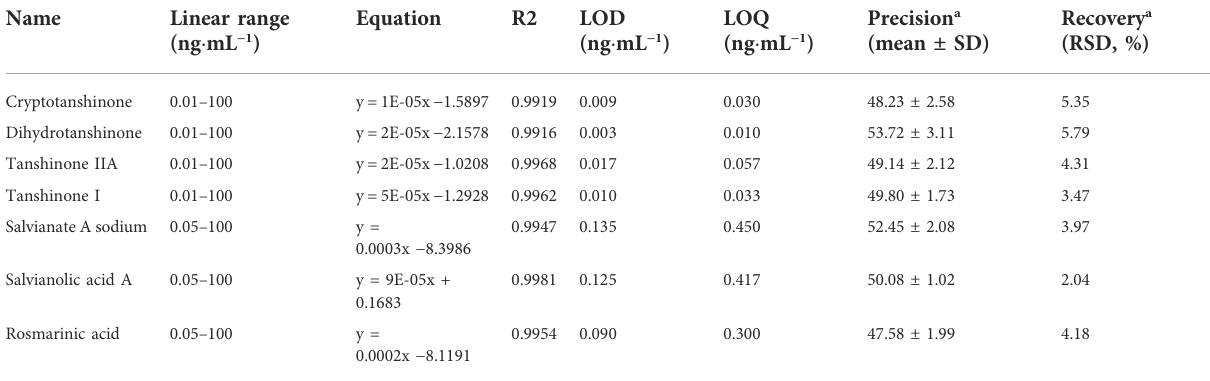
TABLE 2 The results of method validation in terms of linearity, sensitivity, precision, and